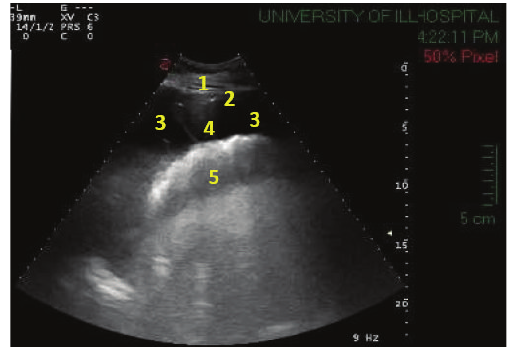
Figure 3: Ultrasonogram of the left thorax at the seventh intercostal space using a 3.5 MHz convex transducer showing pleural e ff usion. 1: thoracic wall; 2: costal pleura; 3: pleural e ff usion; 4: fibrin strands;